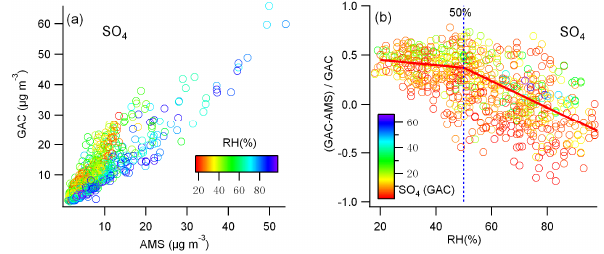
Fig. 14. Scatter plots of (a) the GAC-IC and the AMS for SO 2 − 4 Fig.14. Scatter plots of (a) the GAC-IC and the AMS for SO 42– measurement with measurement with color-coded according to the RH (1-h average color-coded according to the RH (1-hour average data); (b) the relative difference of data); (b) the relative difference of SO 2 − measurement between the 4 SO 42– measurement between the GAC-IC and the AMS versus the RH. GAC-IC and the AMS versus the RH.